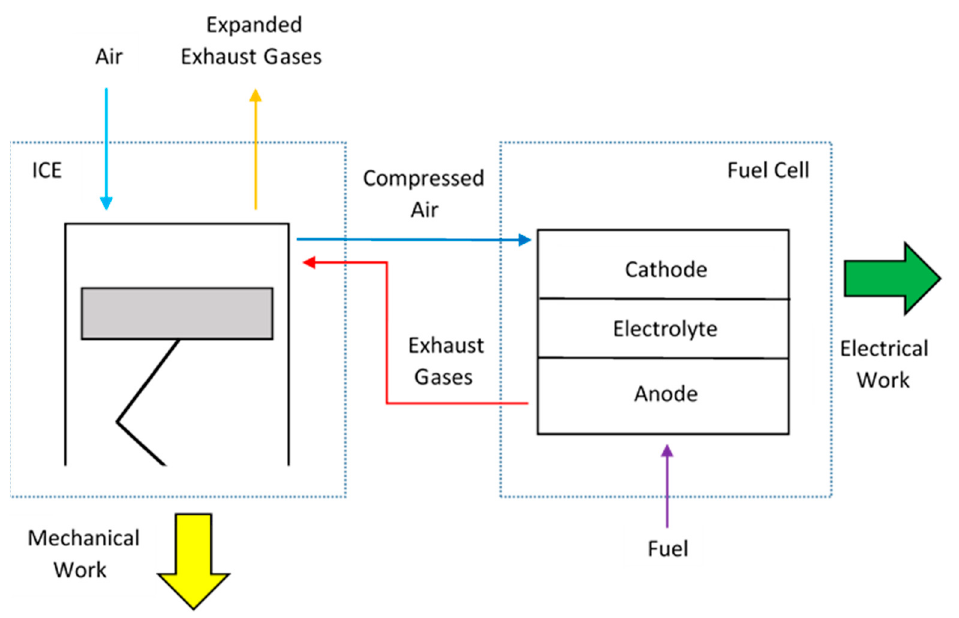
Figure 1. Schematic outline of a fuel cell–internal combustion engine (ICE) hybrid cycle. Air is compressed in the ICE and then reacts in the electrochemical device (fuel cell) to produce electrical power. Hydrogen-rich fuel cell exhaust gases combust and expand in the ICE to produce mechanical work.